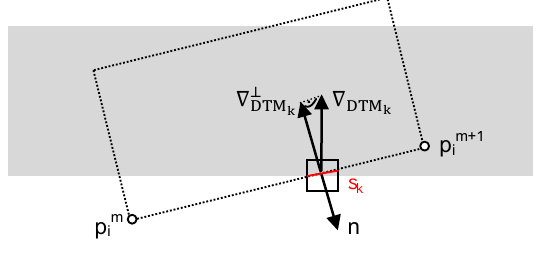
Figure 3. The data term is calculated based on the gradient of each pixel k and the normal vector of the rectangle edge (the gray rectangle indicates a channel in the DTM).